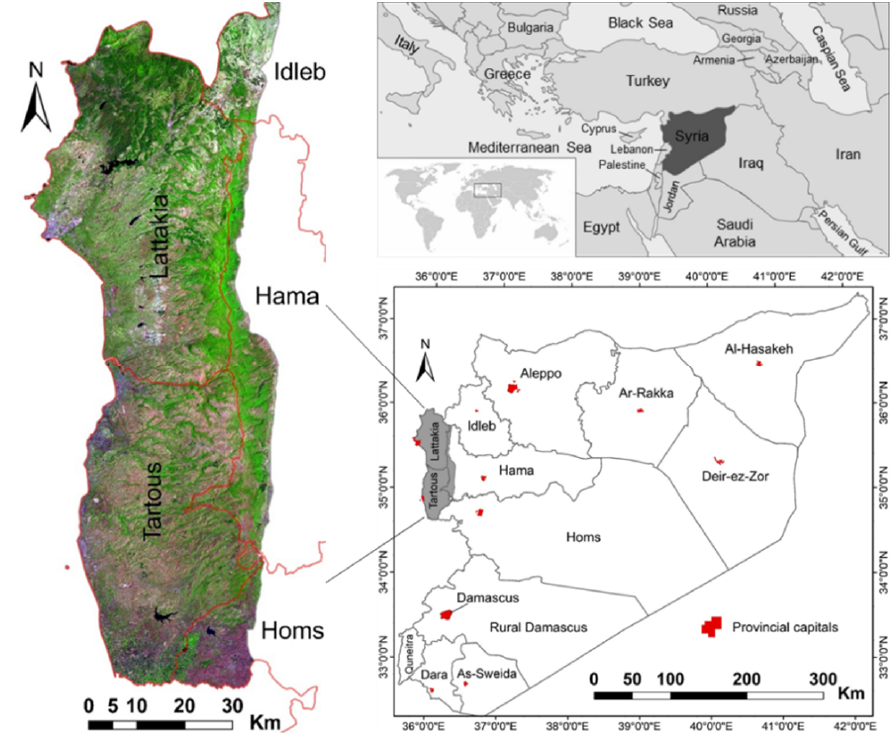
Figure 1. Location of the study area, the 14-governorates administrative divisions ( right ), and false colors composite of Landsat 5 Thematic mapper (TM) image of 2010 (band 6-5-4 as red, green, and blue (RGB) color) ( left ).